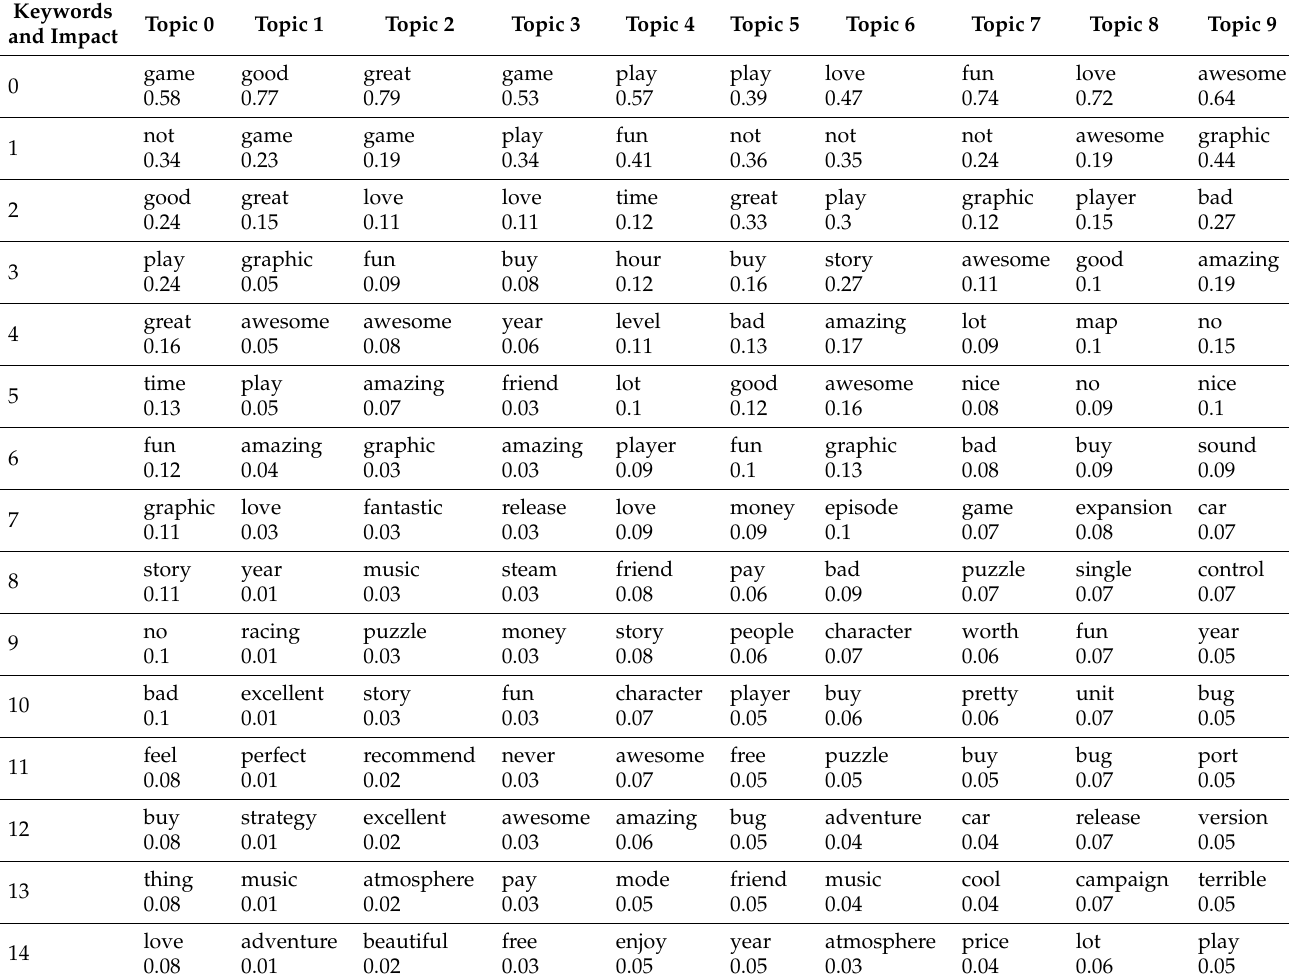
Table 5. The most relevant features for topics generated with LSI.